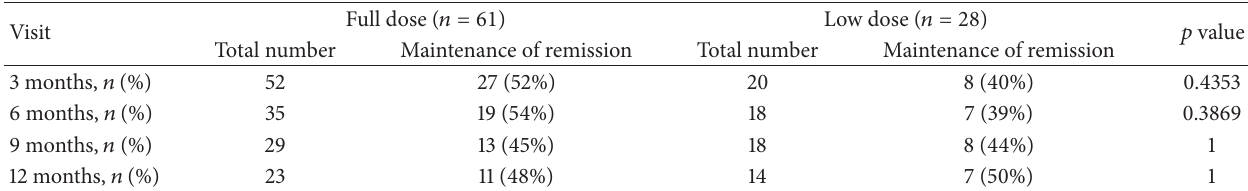
Table 4: Between-group comparison of patients who maintained